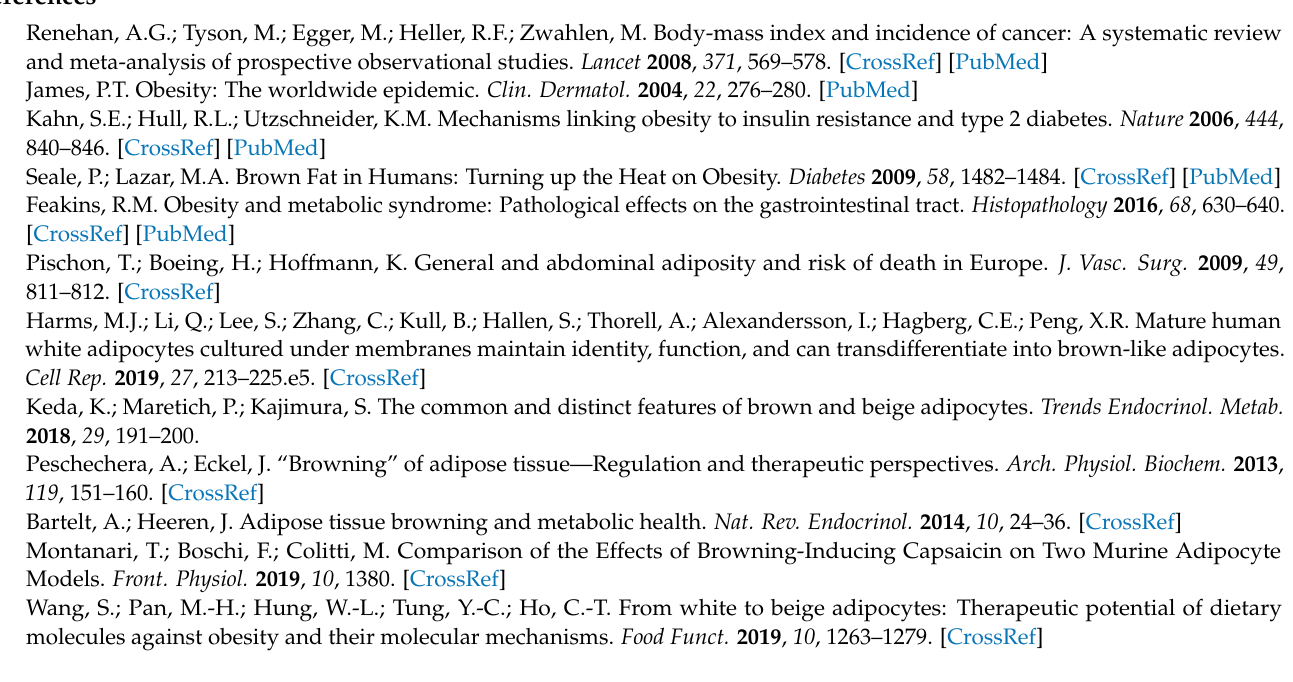
Figure S8. Raw spectra of hBA-CM, hPA-CM and hWA-CM on a slide glass; Table S1: Summarization of objective, methods, results, and discussion of this